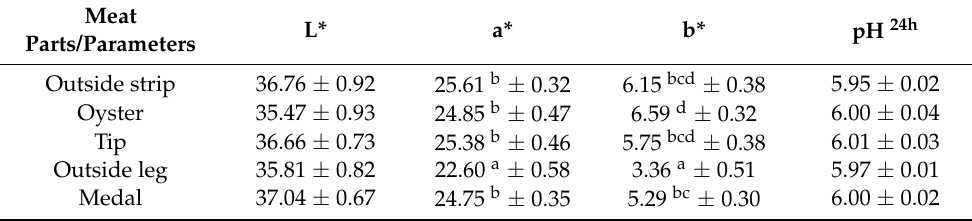
Table 8. The colour and the pH 24h value of the five examined valuable meat parts ( n =